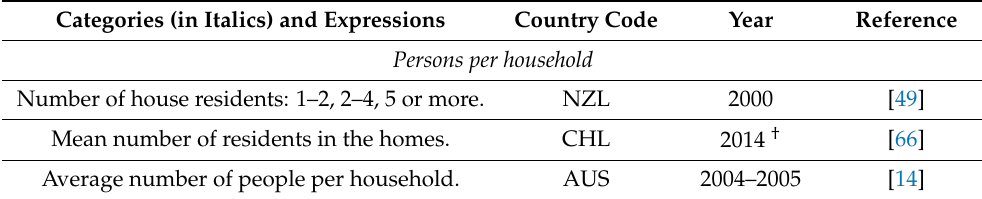
Table A2. Expressions used to describe or define crowdedness in the 100 records included in this scoping review. Country codes are given according to ISO Alpha 3 standard. Country code refers to the location of the dwellings under study. Year refers to when the dwellings were investigated. Categories (in Italics) and Expressions Country Code Year Reference Persons per household Number of house residents: 1–2, 2–4, 5 or more. Mean number of residents in the homes. Average number of people per